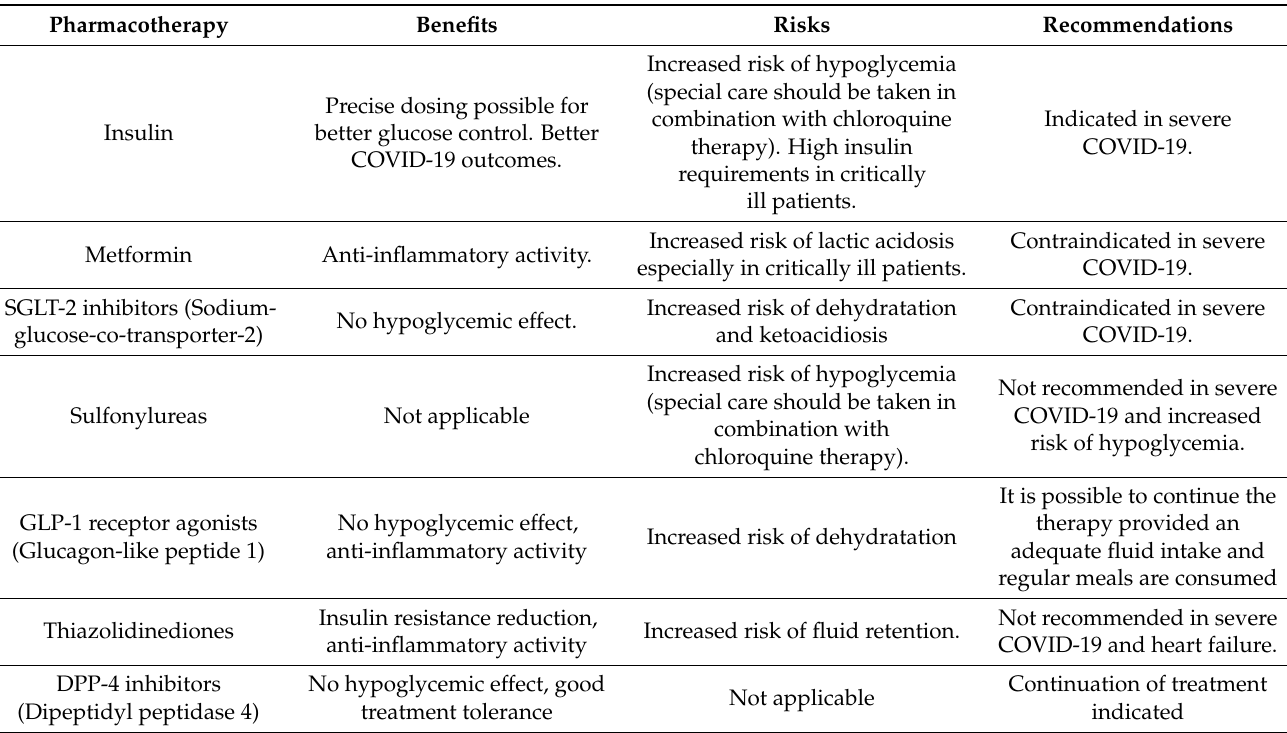
Table 3. Benefits, risks and recommendations for anti-diabetic treatment with COVID-19 and diabetes